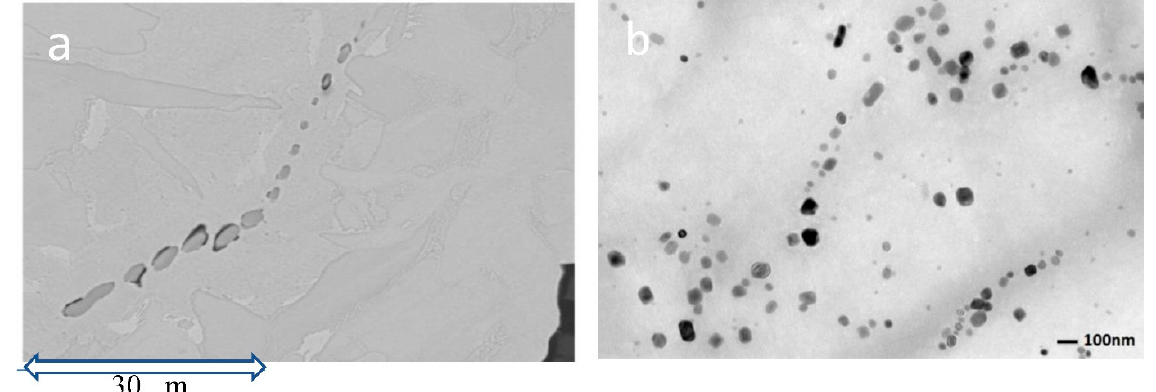
Figure 5. ( a ) Line of MnS inclusions situated at pre-existing austenite grain boundary, with a high Cu-rich rim (black areas) in a TRIP steel with 0.5%Cu tested at 800 °C [7]. ( b ) Nb-Ti carbo-nitrides in a B-containing Al TWIP tested at 1000 °C [3].